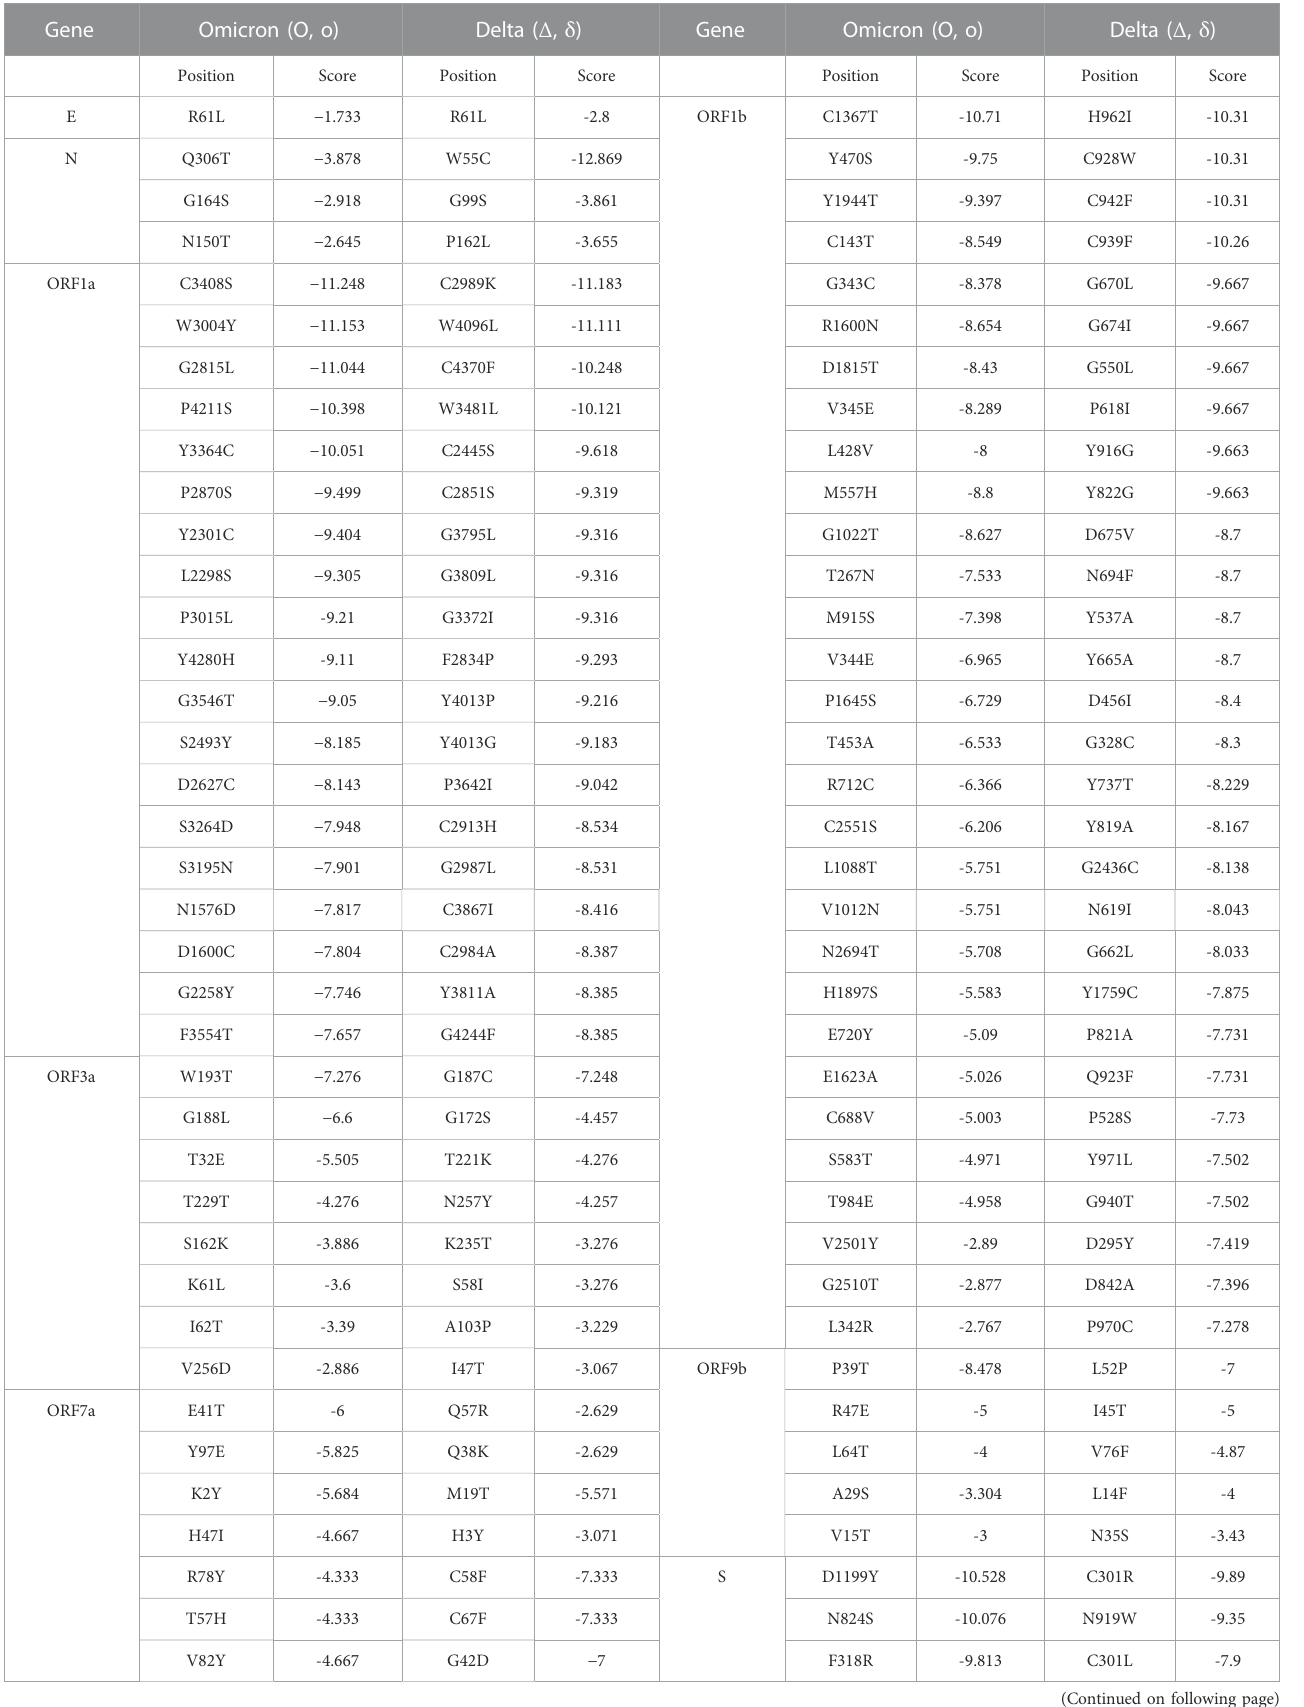
TABLE 3 Comparison of the deleterious mutations between Omicron and Delta variants of SARS-CoV-2 in their different genes. Gene Omicron (O,